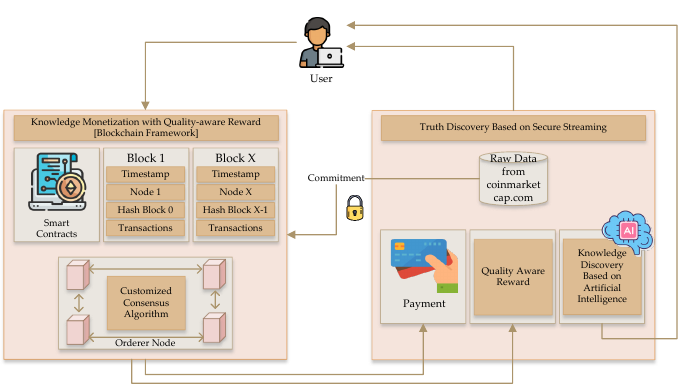
Figure 1. Overview of the proposed knowledge discovery in a blockchain